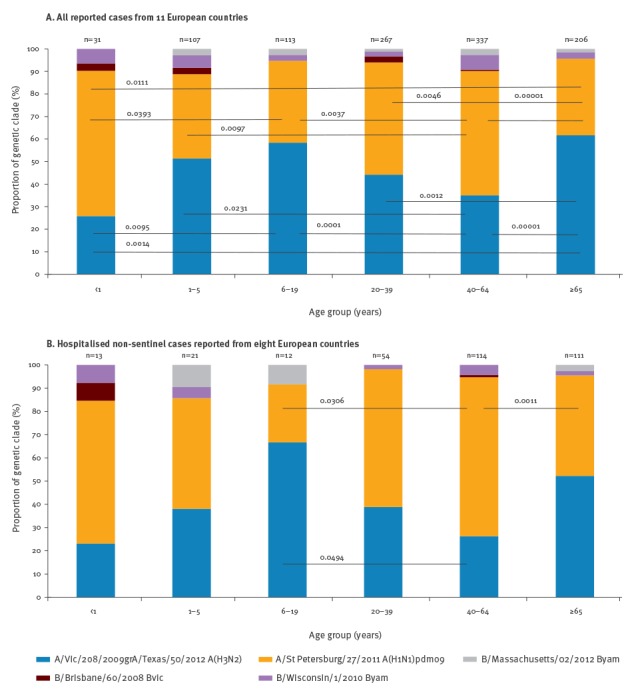
Proportions of influenza virus genetic clades by patient age, strain-based reporting of antigenic and genetic characterisation data from (A) all reported cases with age from 11 European countries (n = 1,061) and (B) hospitalised non-sentinel cases reported from eight European countries (n = 325), influenza season 2013/14